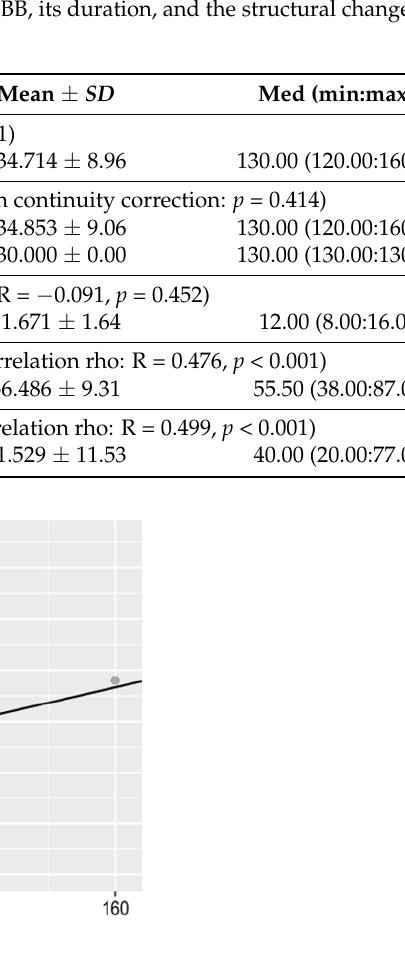
Figure 3. The relationship between the LBBB-QRS complex duration and systolic diameter of the left ventricle. LV—left ventricle.